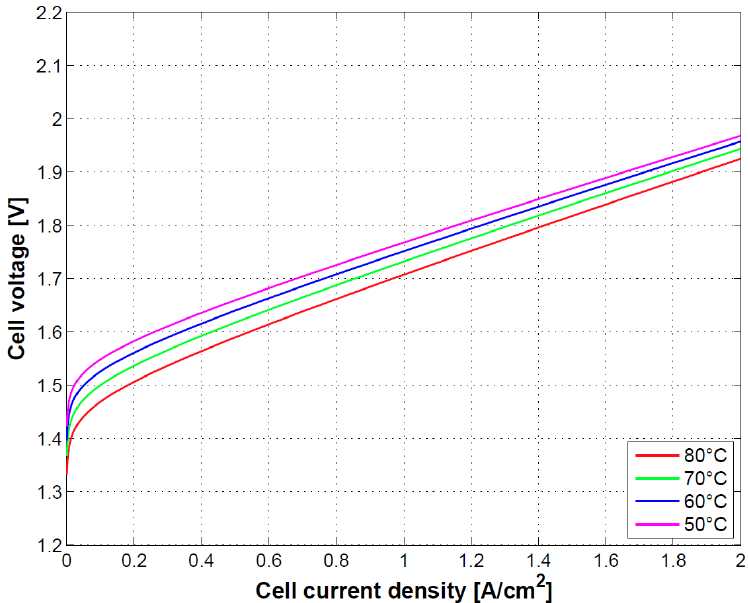
Figure 6. Modelling results of the polarization curve at different temperature of operation.